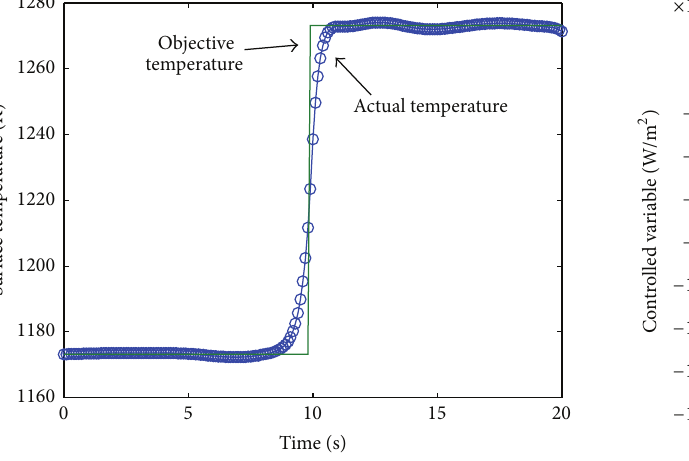
Figure 4: Surface temperature of billet.